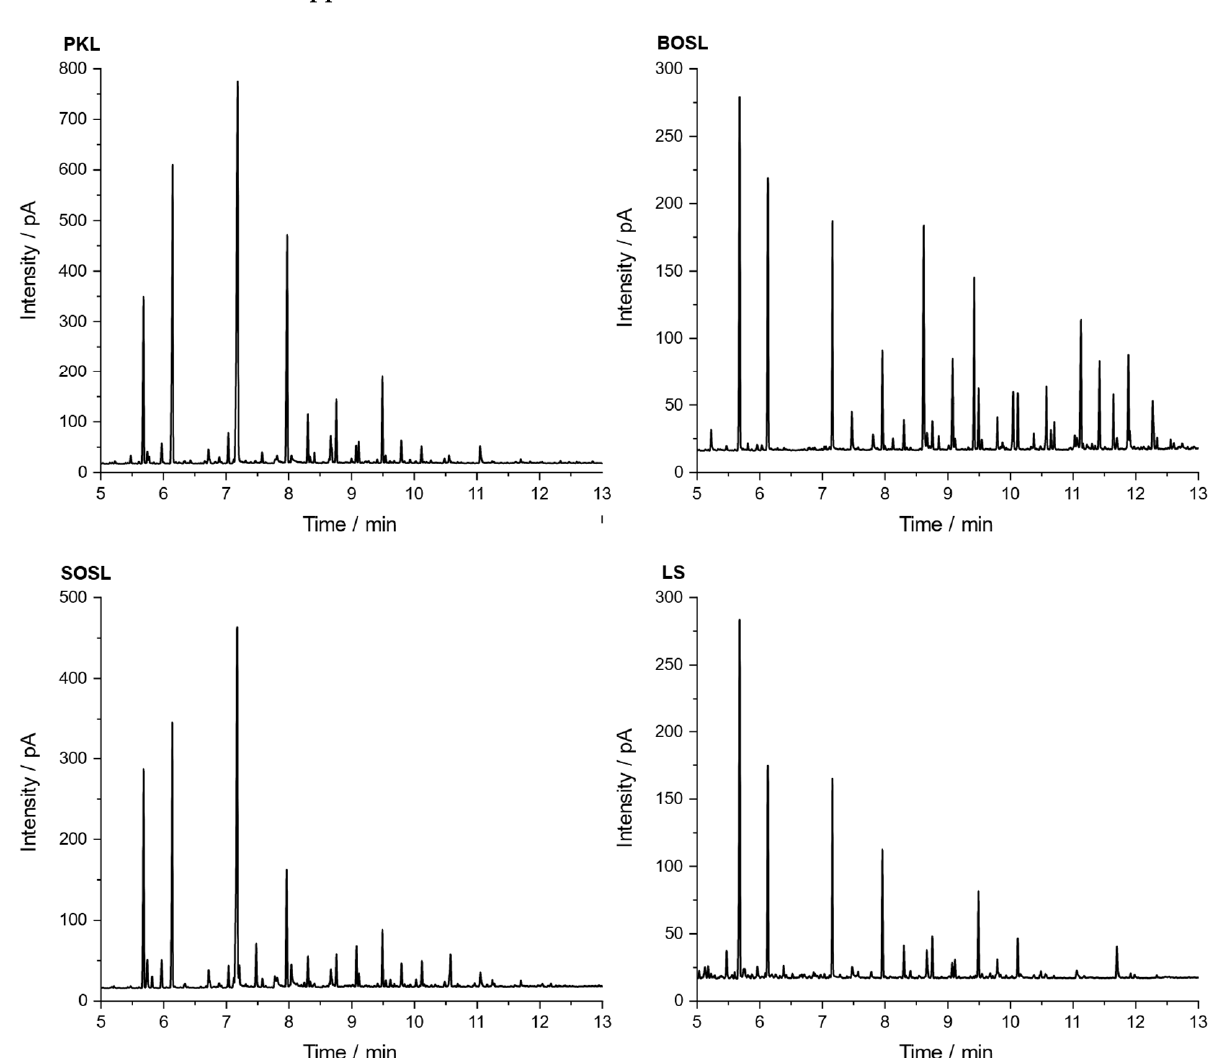
Figure A1. Chromatograms of the four bio-oils obtained by GC-FID.